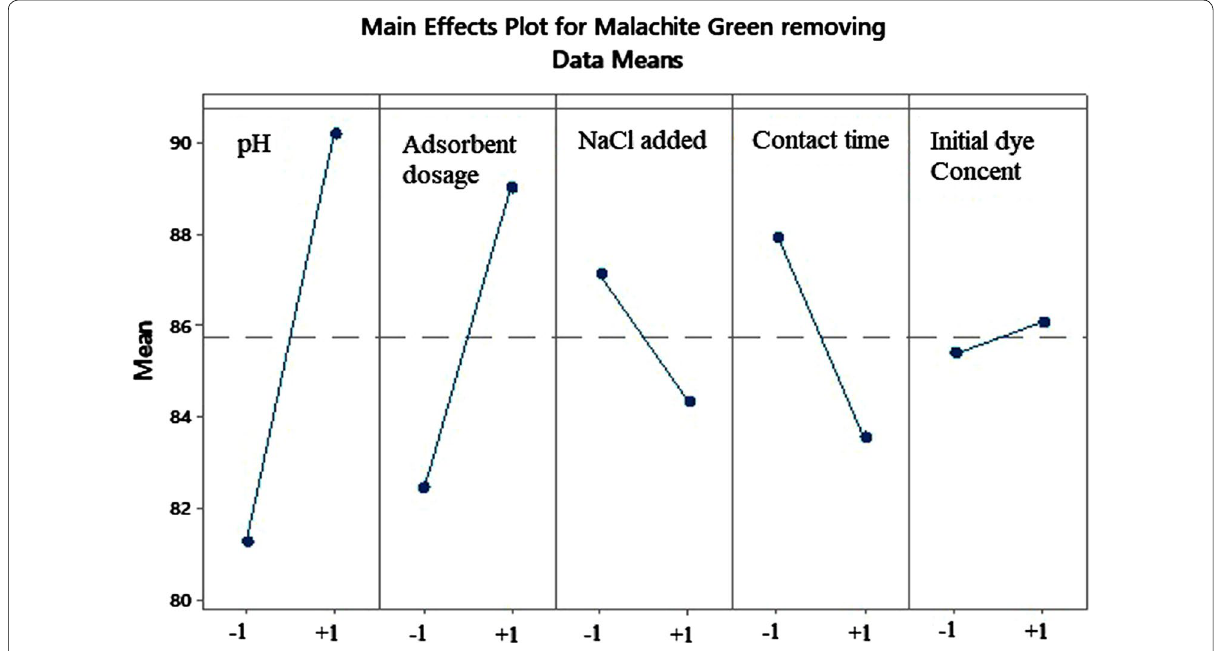
Fig. 5 Main effects plot for MG removal by PBD